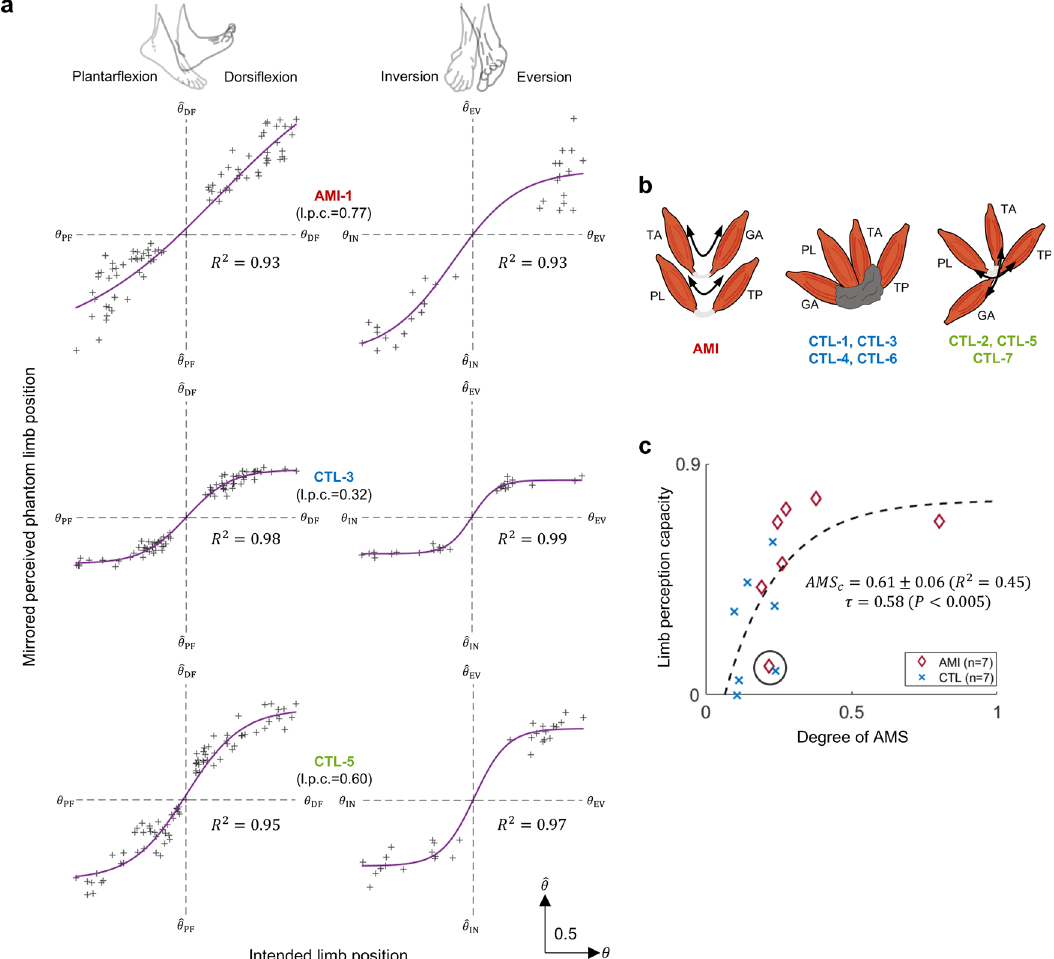
Fig. 5 Subject-speci fi c proprioceptive perception. In a , relationships are shown between the mirrored perceived phantom limb position as measured from the biologically-intact limb without visual feedback and the intended phantom limb positions for three representative subjects (AMI-1, CTL-3, and CTL-5), who had respectively undergone Agonist-antagonist Myoneural Interface (AMI), traditional, and Ertl osteomyoplasty amputation procedures. Estimated limb perception capacity (l.p.c.) is reported. In b , schematic diagrams are shown of the anticipated residual limb structures, based on ultrasonography, highlighting the dynamic AMI construct excursion in 2-DoF for AMI, restricted motion in control subjects (CTL-1, CTL-3, CTL-4, and CTL-6), and ‘ joystick- like ’ residual muscle coupling in control subjects (CTL-2, CTL-5, and CTL-7). Size and positioning of elements are representative and not to scale. In c , limb perception capacity of the phantom limb is plotted against the degree of agonist-antagonist muscle strain (AMS) in a combined analysis of affected AMI and CTL limbs ( n = 14). Kendall ’ s tau correlation ( τ ), P , R 2 , and the Jackknife mean and s.d. of a critical degree of AMS ( AMS c ) are reported. The limb perception capacity for AMI-2 and CTL-2 (encircled) deviated from the